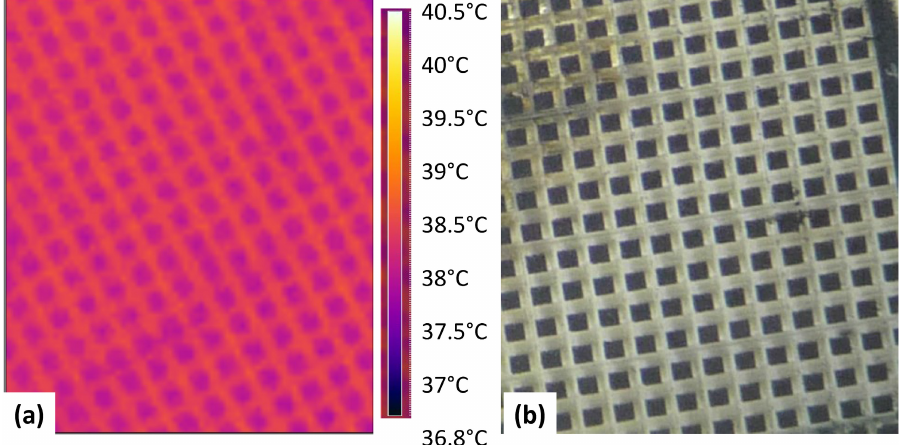
Figure 5. View of a pattern with 50 µm × 50 µm CNT array nano-pillars grown on a quartz substrate: ( a ) Infrared thermography with a resolution size of 25 µm × 25 µm per pixel on a constant temperature polyimide source (30 °C). ( b ) Optical microscope